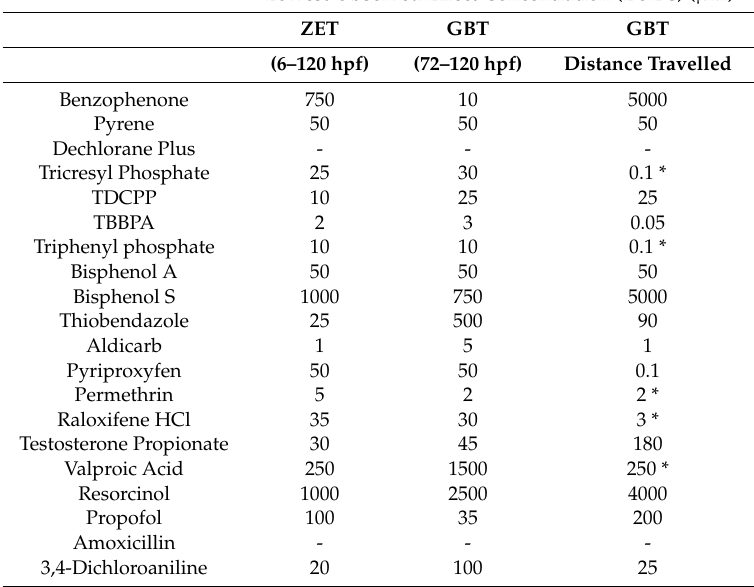
Table 4. Lowest observed e ff ect concentrations (LOEC) for each compound based on the phenotypic observations in the ZET / GBT assays and any change in behaviour for the GBT assay. All values are expressed in µ M. LOEC values for the behavioral changes of the GBT assay marked with an asterisk (*) denote LOEC concentrations where the distance travelled by exposed larvae was higher than the carrier controls. The statistical values for the behavioral LOEC calculations are included as Supplementary Data (see Supplementary Table